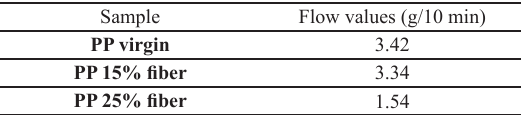
Table 4. Fluidity index results of composites and virgin PP. Sample